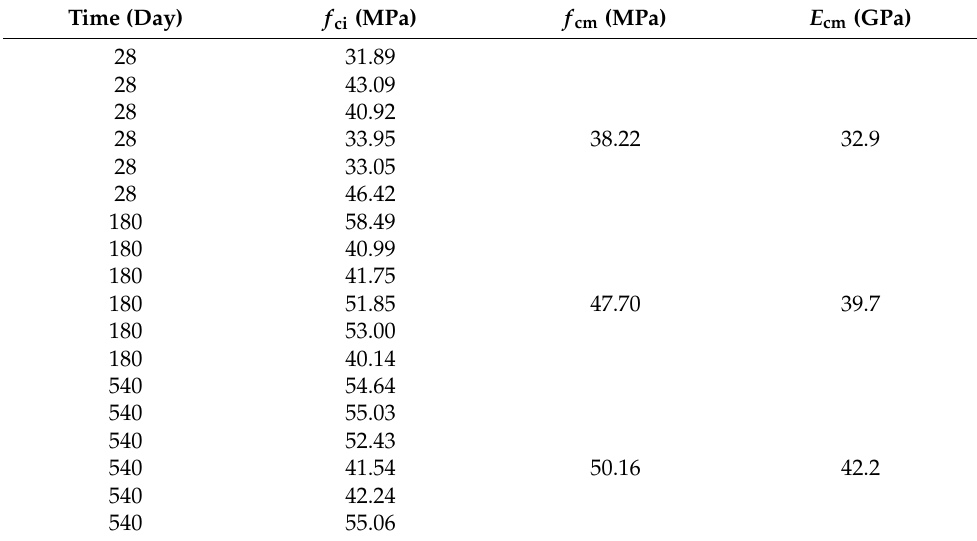
Table A1. Compressive strength of concrete in the test elements determined by testing cylindrical specimens with a diameter of 150 mm and a height of 300 mm after 28, 180, and 540 days from setting them in